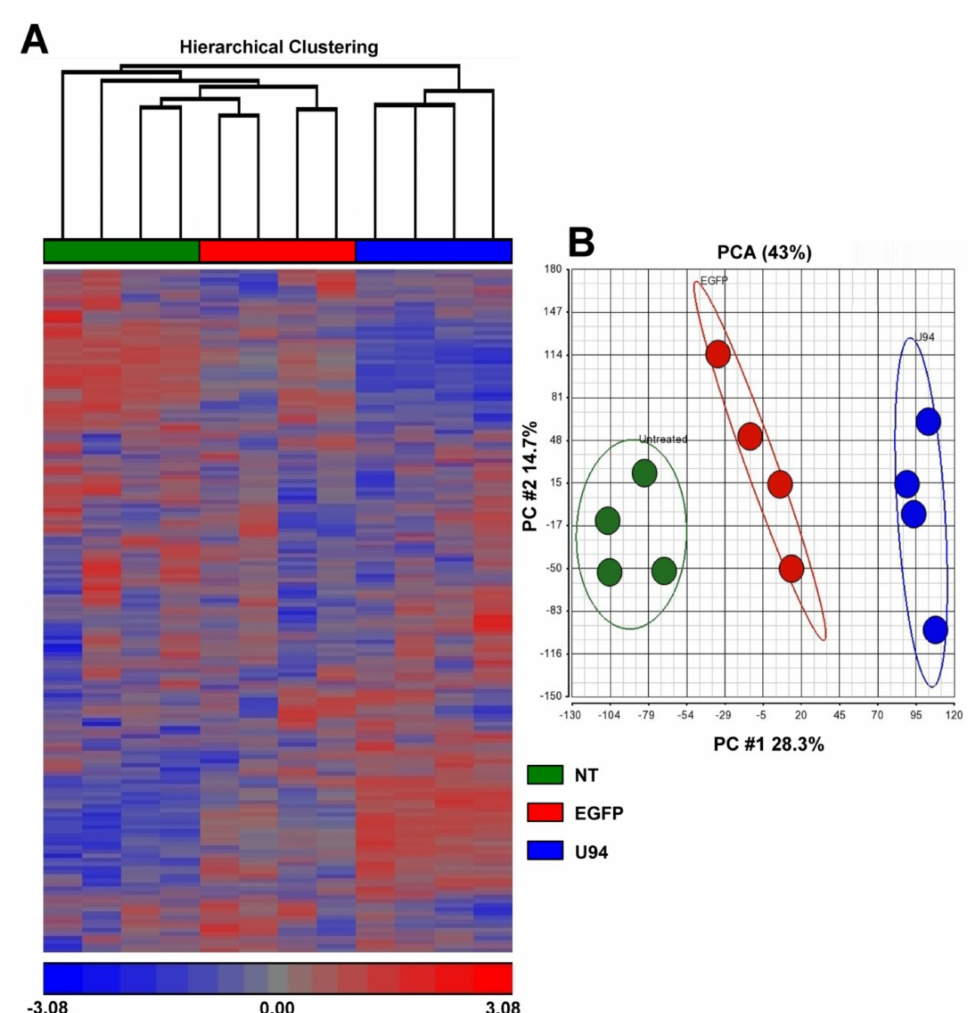
Figure 1. Transcriptional profile of MDA-MB 231 breast cancer cells expressing U94. ( A ) Unsupervised hierarchical clustering of MDA-MB 231 breast cancer cell line not treated (NT) (green), expressing EGFP (EGFP + ) control (red) or expressing U94 (U94 + ) (blue) performed on 18537 genes obtained after normalization and filtering procedures ( n = 4 samples / group). ( B ) Principal Component Analysis (PCA) conducted on 18537 genes obtained after normalization and filtering procedures ( n = 4 samples / group) expressed by MDA-MB 231 cells NT (green), EGFP + control (red) or U94 + (blue). Each dot represents a